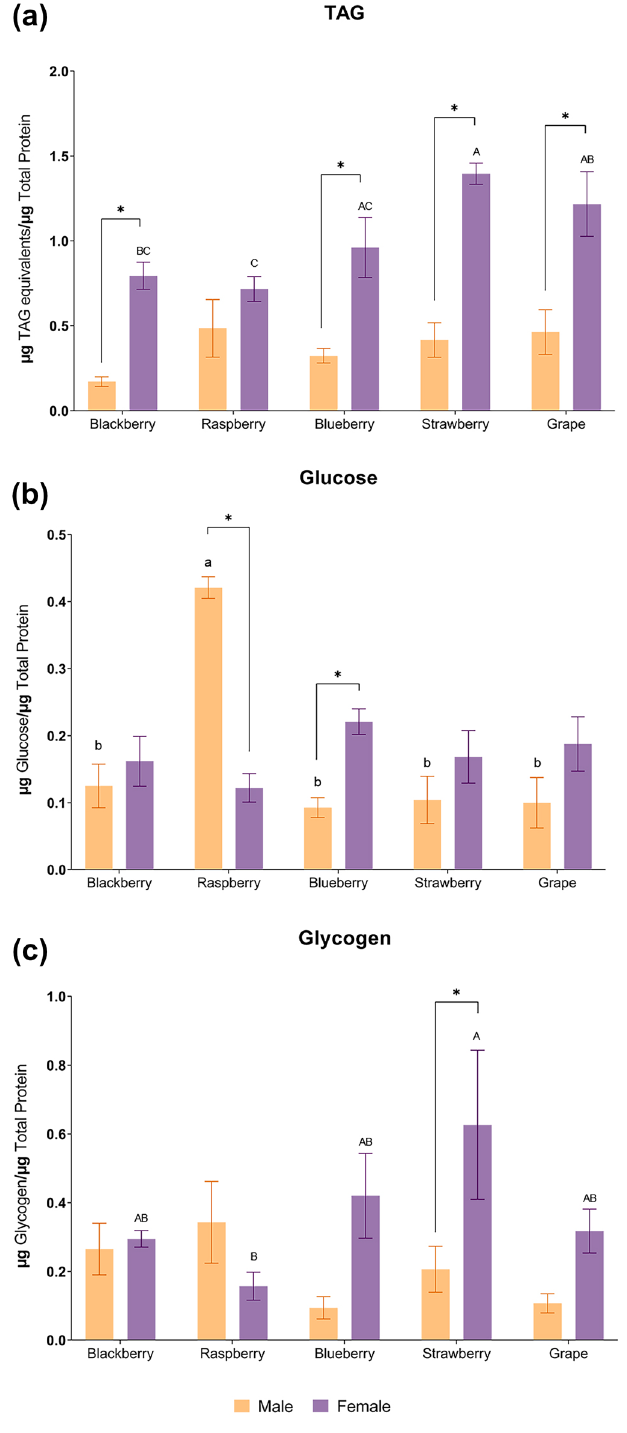
Figure 2. Enzymatic quantification of TAG ( a ), Glucose ( b ) and Glycogen ( c ) in adult male and female SWD. Different lowercase letters represent statistically significant differences (p < 0.05) between males, different uppercase letters represent statistically significant differences (p < 0.05) between females, and * represent statistically significant differences (p < 0.05) between males and females fed on a specific fruit media. No lowercase or uppercase letter means there was no significant difference among treatments within males or females,